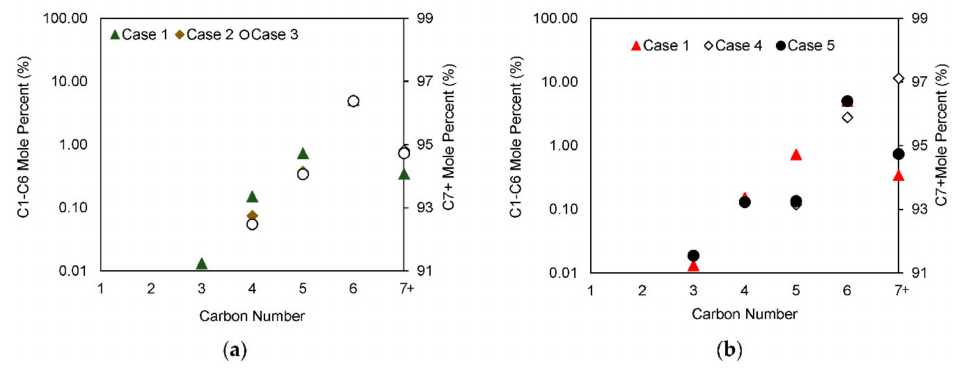
Figure 4. Gas chromatography (GC) results at ( a ) 131 ◦ F and ( b ) 158 ◦ F.